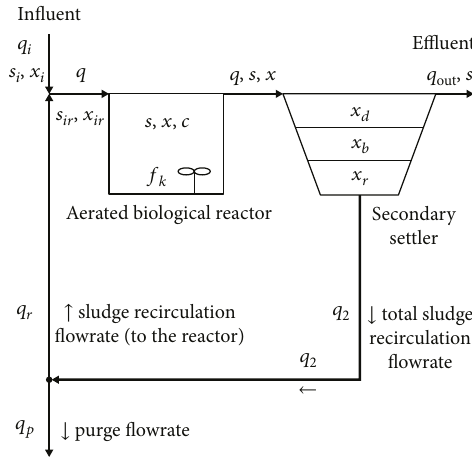
Figure 1: Wastewater treatment plant with activated